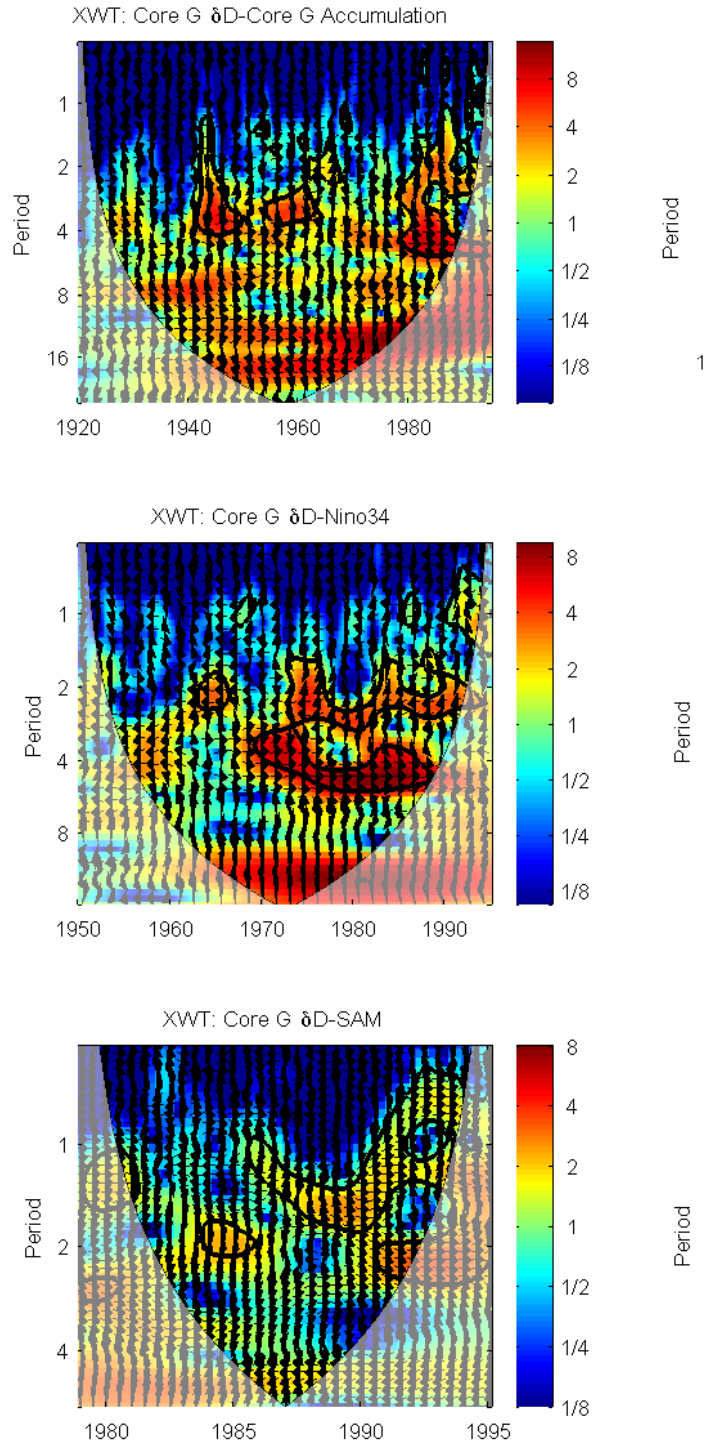
Figure A3. Top panel: core D δ D and core D net accumulation XWT from 1657 to 1995. Middle panel: core D δ D and Niño 3.4 XWT from 1950 to 1995. Bottom panel: core D δ D and SAM XWT from 1979 to